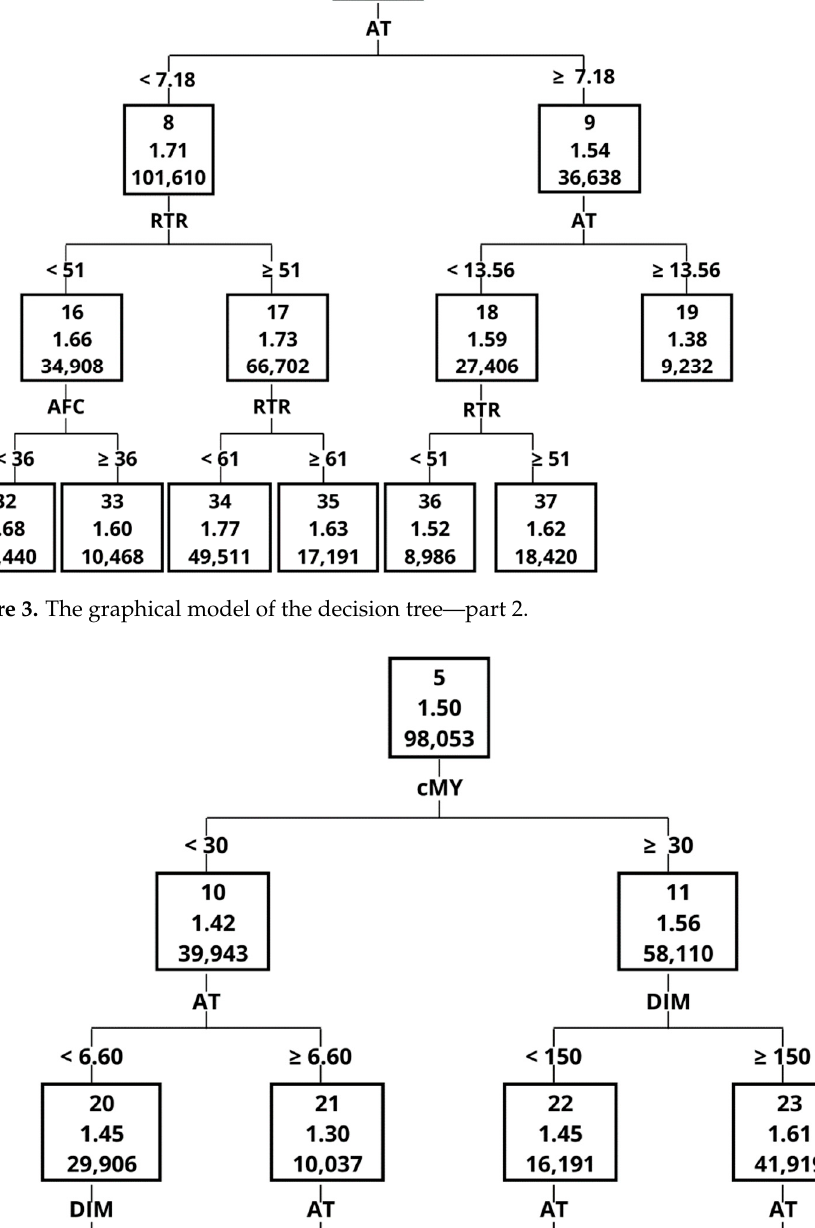
Figure 4. The graphical model of the decision tree—part 3.